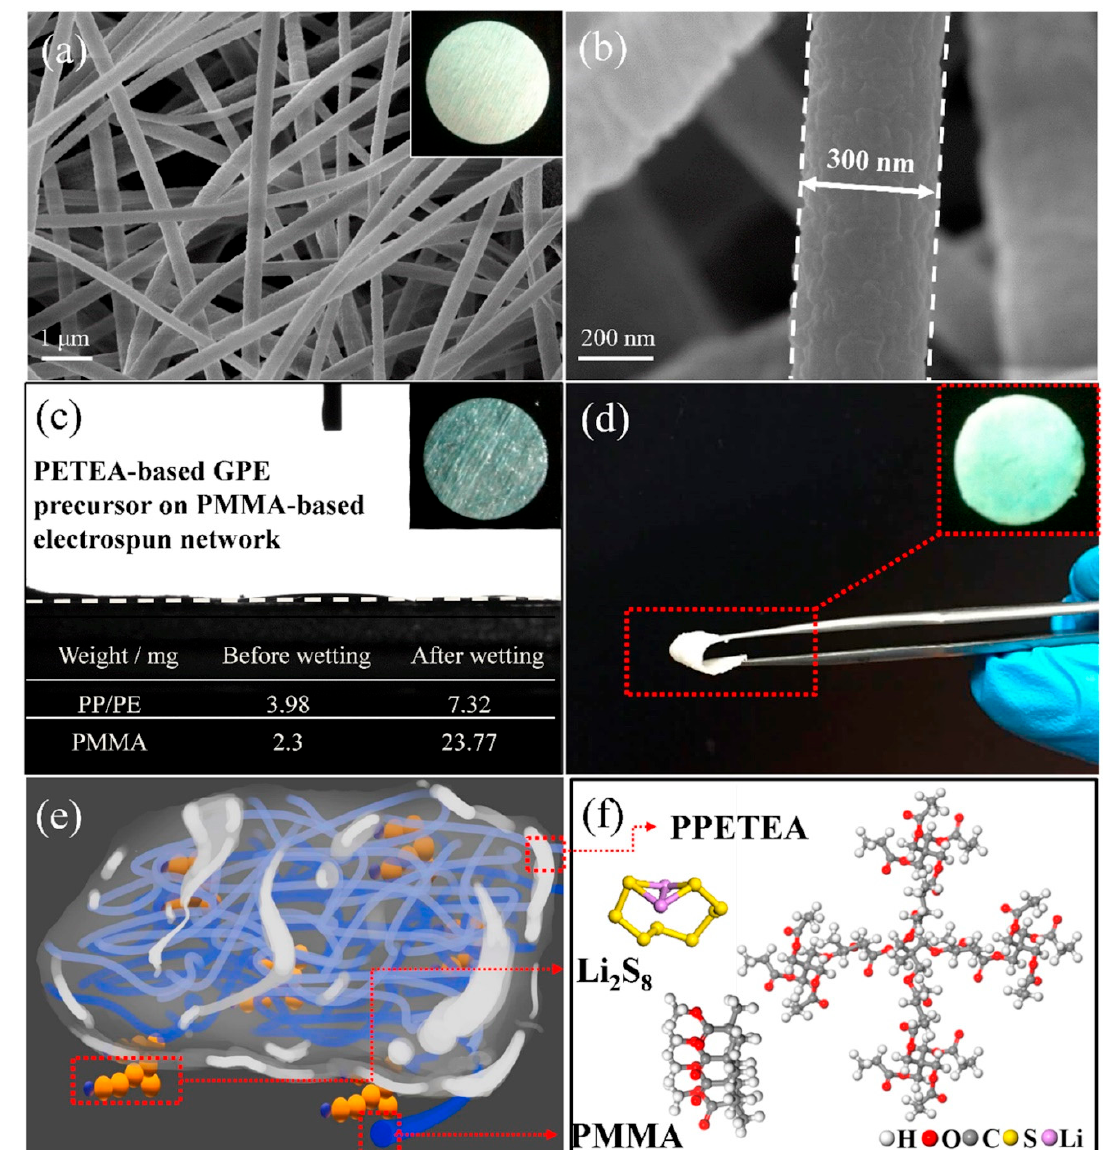
Figure 9. ( a , b ) Scanning electron microscopy image of PMMA-based electrospun fiber network; ( c ) uptake ability of the PMMA-based electrospun fiber network GPE; ( d ) optical image of AHE; ( e , f ) schematic representation of atomic configurations of AHE. (Reprinted with permission from [132]; Copyright 2016, Electrochim. Acta 2016 , 213 , 871–878.)